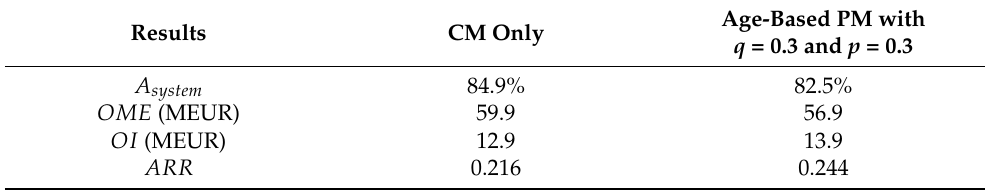
Table 15. Main system results for CM and optimum age-based